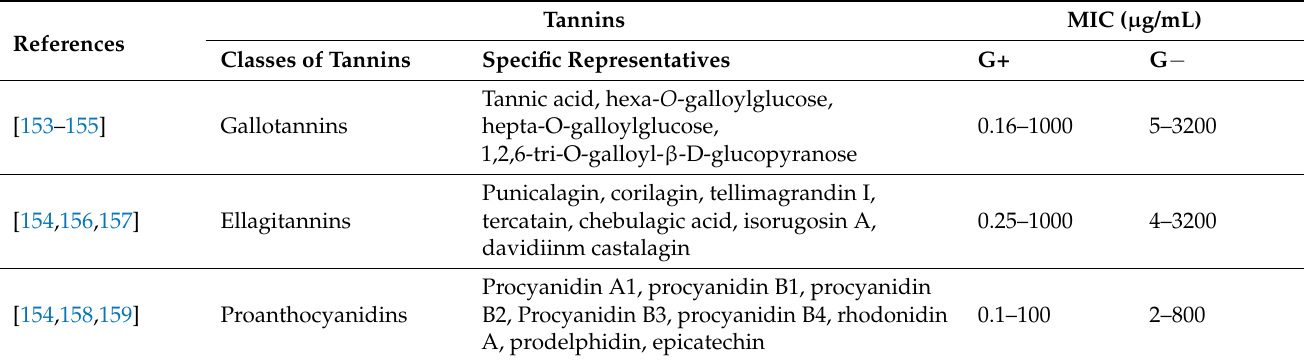
Table 5. The minimum inhibitory concentrations of selected tannins against gram-positive and gram-negative